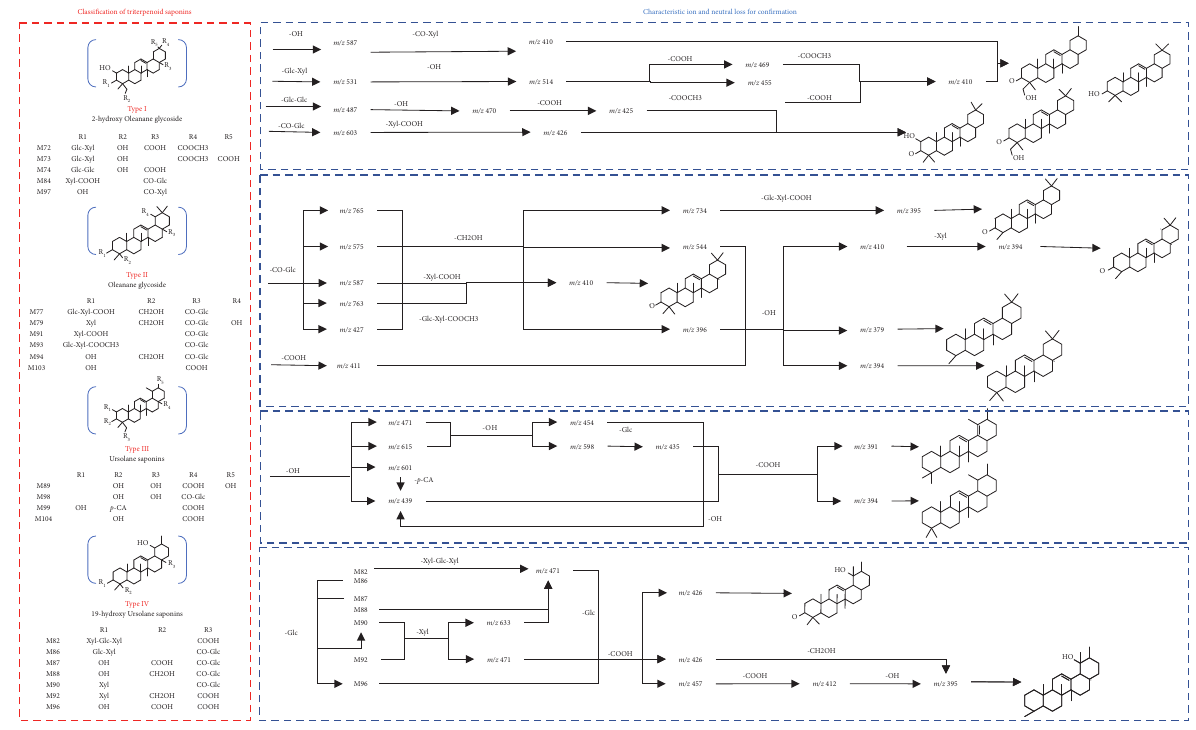
Figure 3: Types of triterpenes and their cracking regularity in